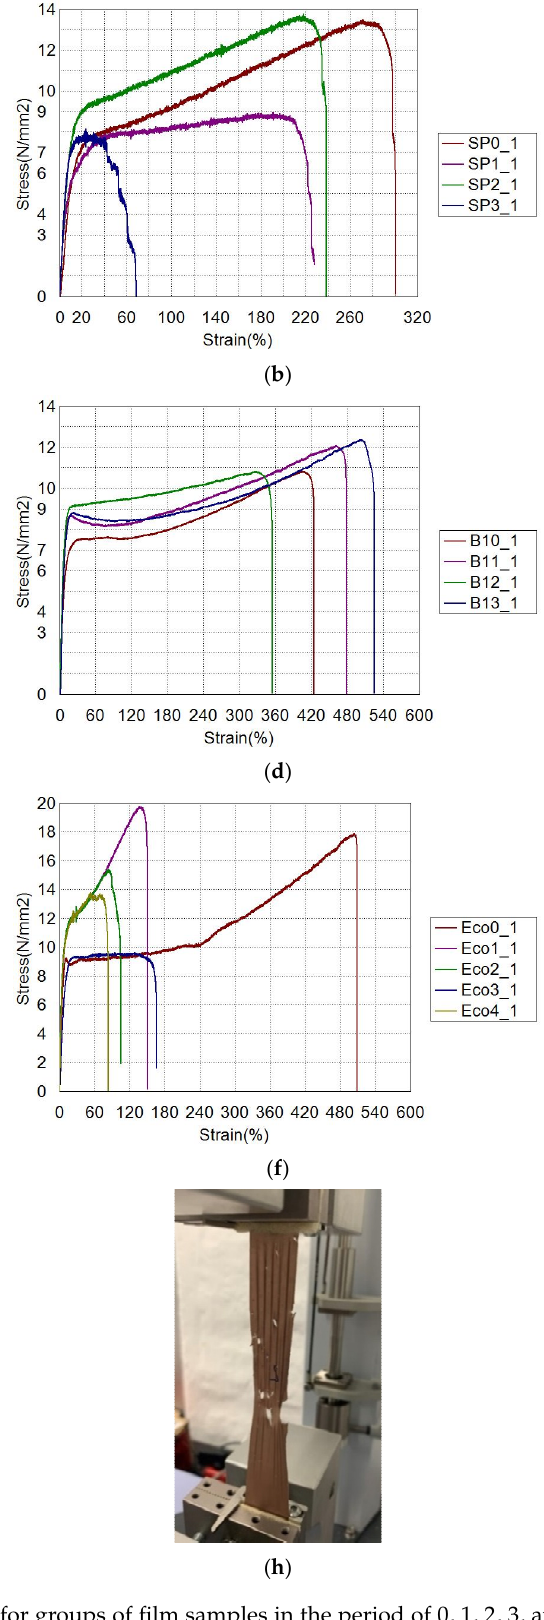
Figure 5. Testing procedure and tensile stress-strain diagrams for groups of film samples in the period of 0, 1, 2, 3, and 4 months: ( a ) B0, ( b ) SP, ( c ) SW, ( d ) B1, ( e ) B2, ( f ) ECO, ( g ) K, ( h ) procedures of testing. The diagrams show that only after 3 or 4 months of decomposition a greater decrease in mechanical properties is observed.